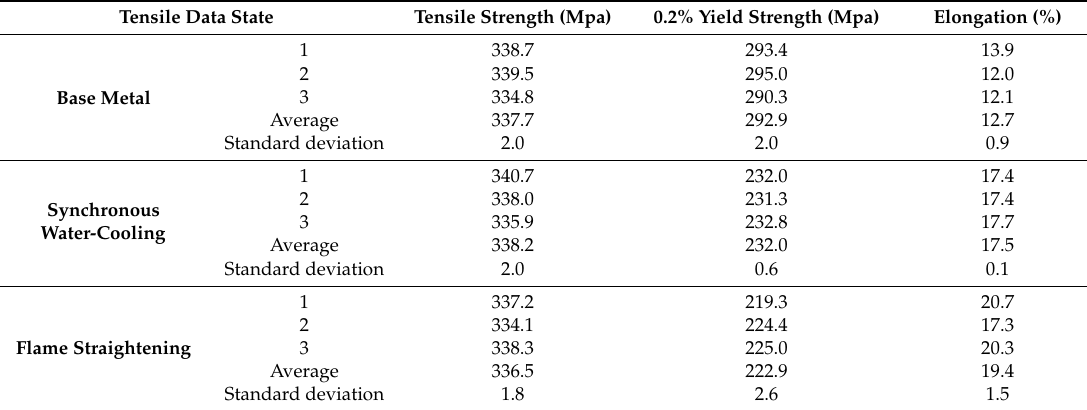
Figure 7. Macroscopic tensile fracture after ( a ) flame straightening and ( b ) synchronous water-cooling. Table 2. Tensile test results.